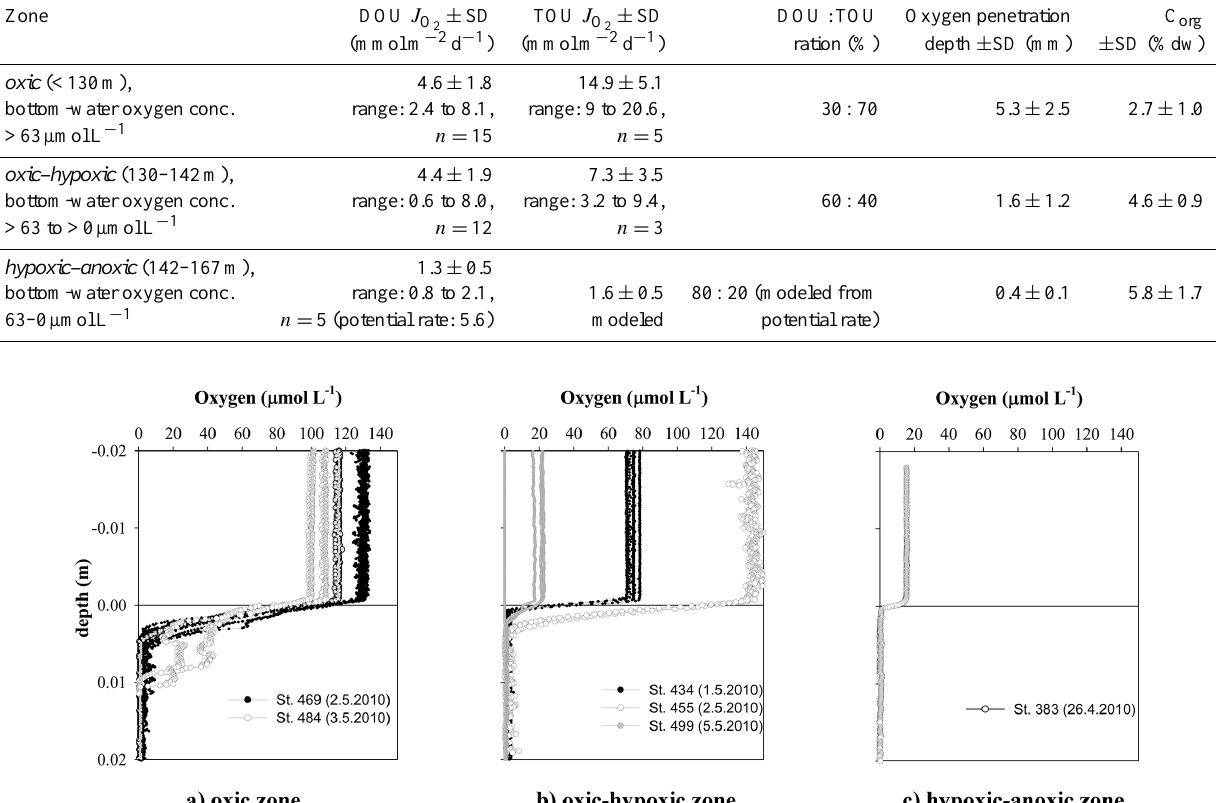
Figure 5. Examples of high-resolution oxygen profiles under different oxygen regimes. Differences in bottom-water oxygen concentrations (reflected in profile shape and oxygen penetration depth) are clearly visible between sites and deployments.